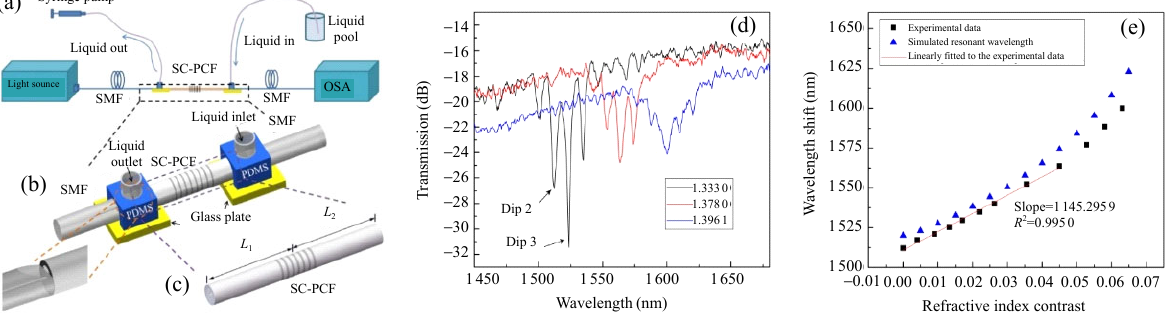
Fig. 9 Schematic diagrams of the inline optofluidic sensing platform and RI response of the LPFG sensor based on the PCF